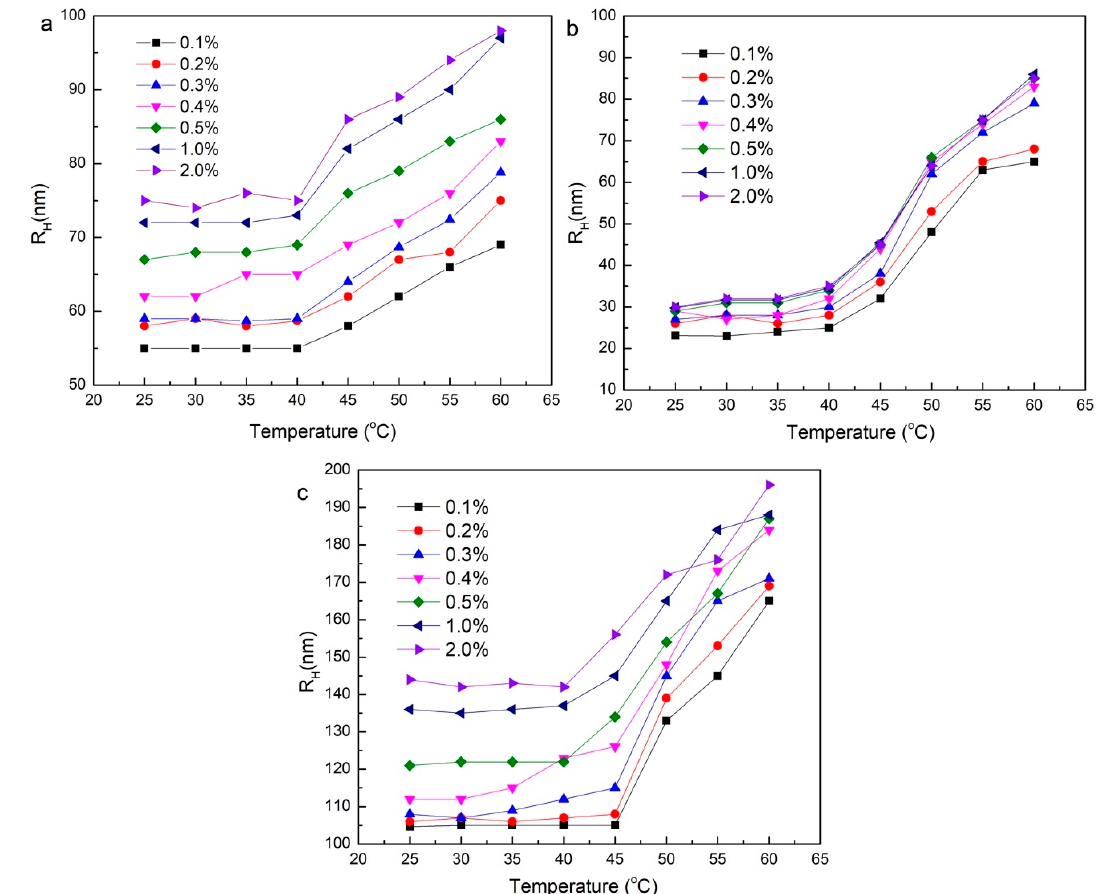
Figure 9. The hydrodynamic radius ( R H ) versus the temperature for S2, S3, S4 aqueous solutions with different concentrations and temperatures, respectively.